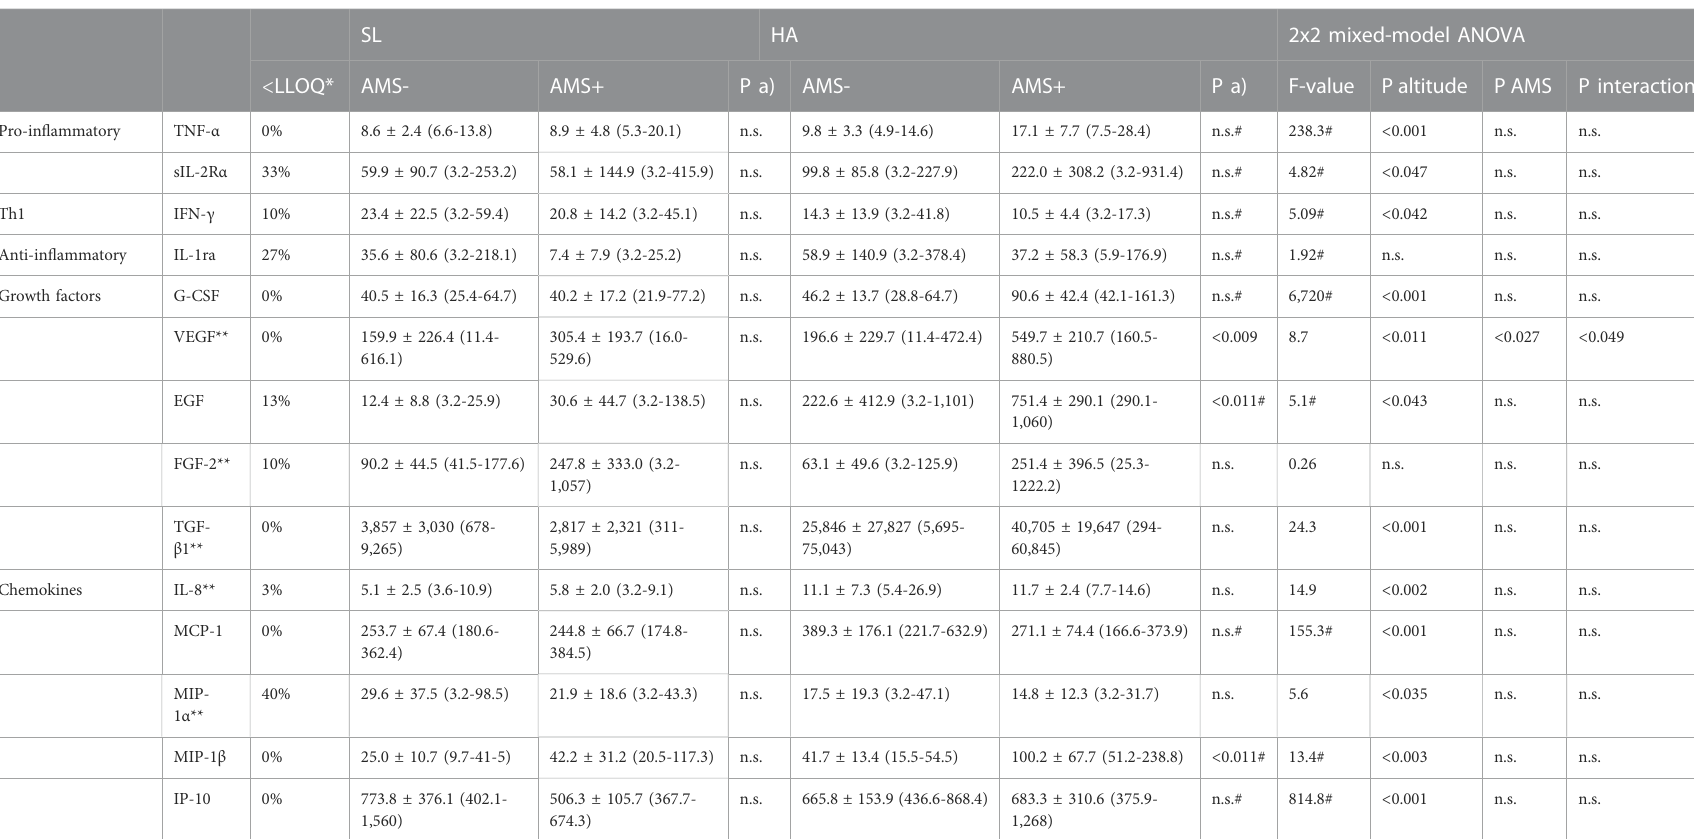
TABLE 2 Serum levels of cytokines (pg/ml) at sea-level (SL) and one day after arrival at high-altitude in 5,050 m (HA) according to AMS groups. Cytokine levels are given as mean ± standard deviation (with minimum and maximum values); *proportion of samples with values detected below the lower limit of quanti fi cation (LLOQ), biomarkers with values below LLOQ in > 50% of samples were excluded from statistical analysis;